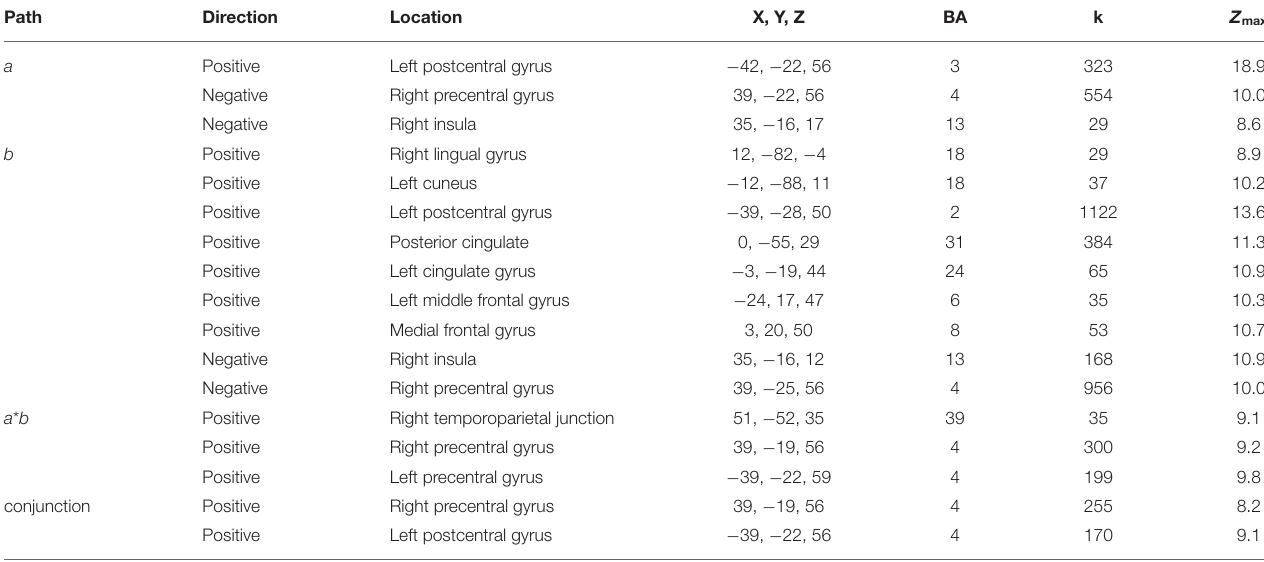
TABLE 1 | Summary of the clusters that showed significant effects in the multilevel mediation analysis. Path